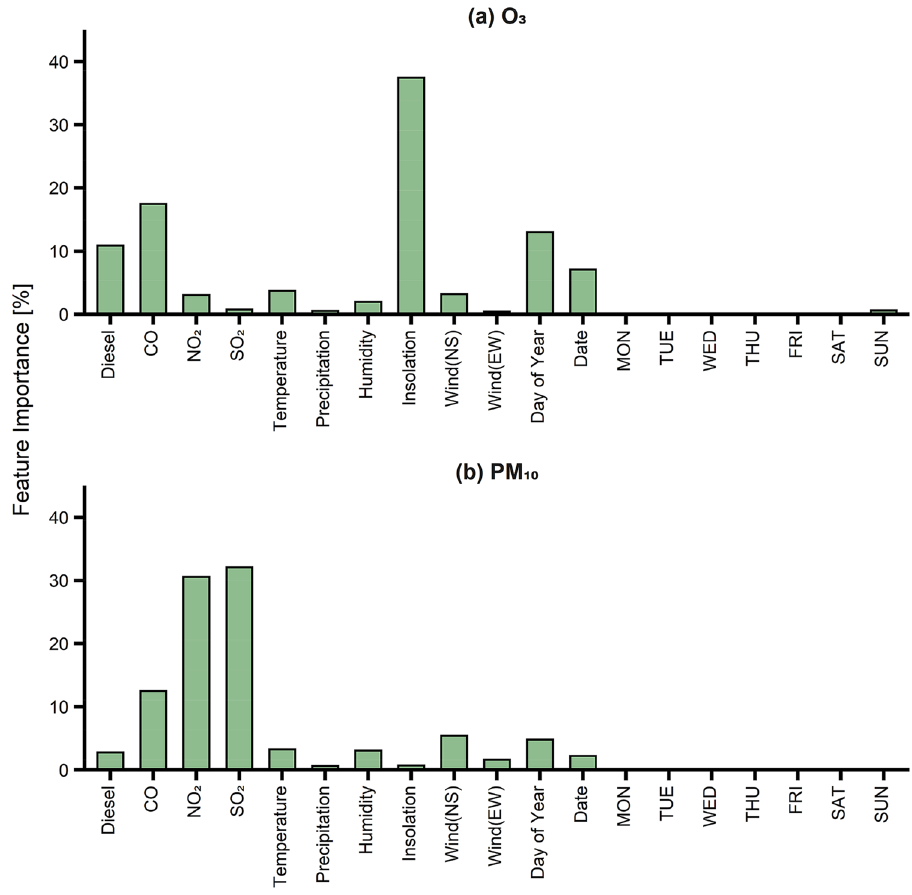
Figure 2. Feature importance of ( a ) O 3 and ( b ) PM 10 .